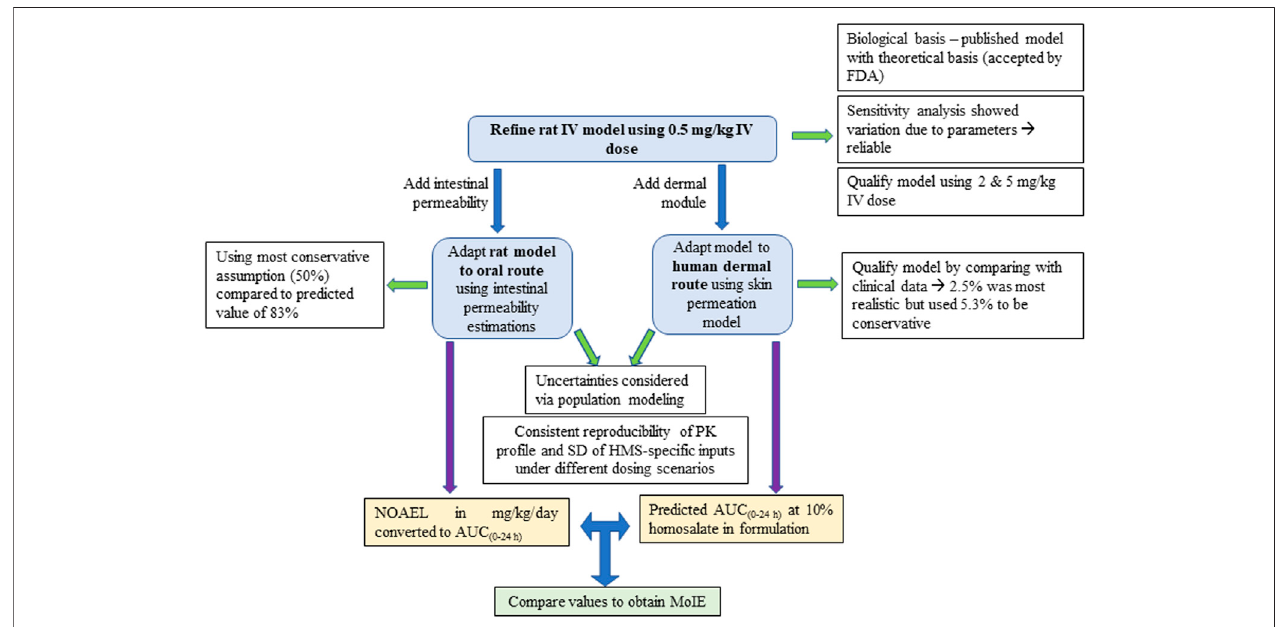
FIGURE 5 | An overview of the development of the PBK models, together with the associated assessments for model quali fi cation and the derivation of the MoIE.